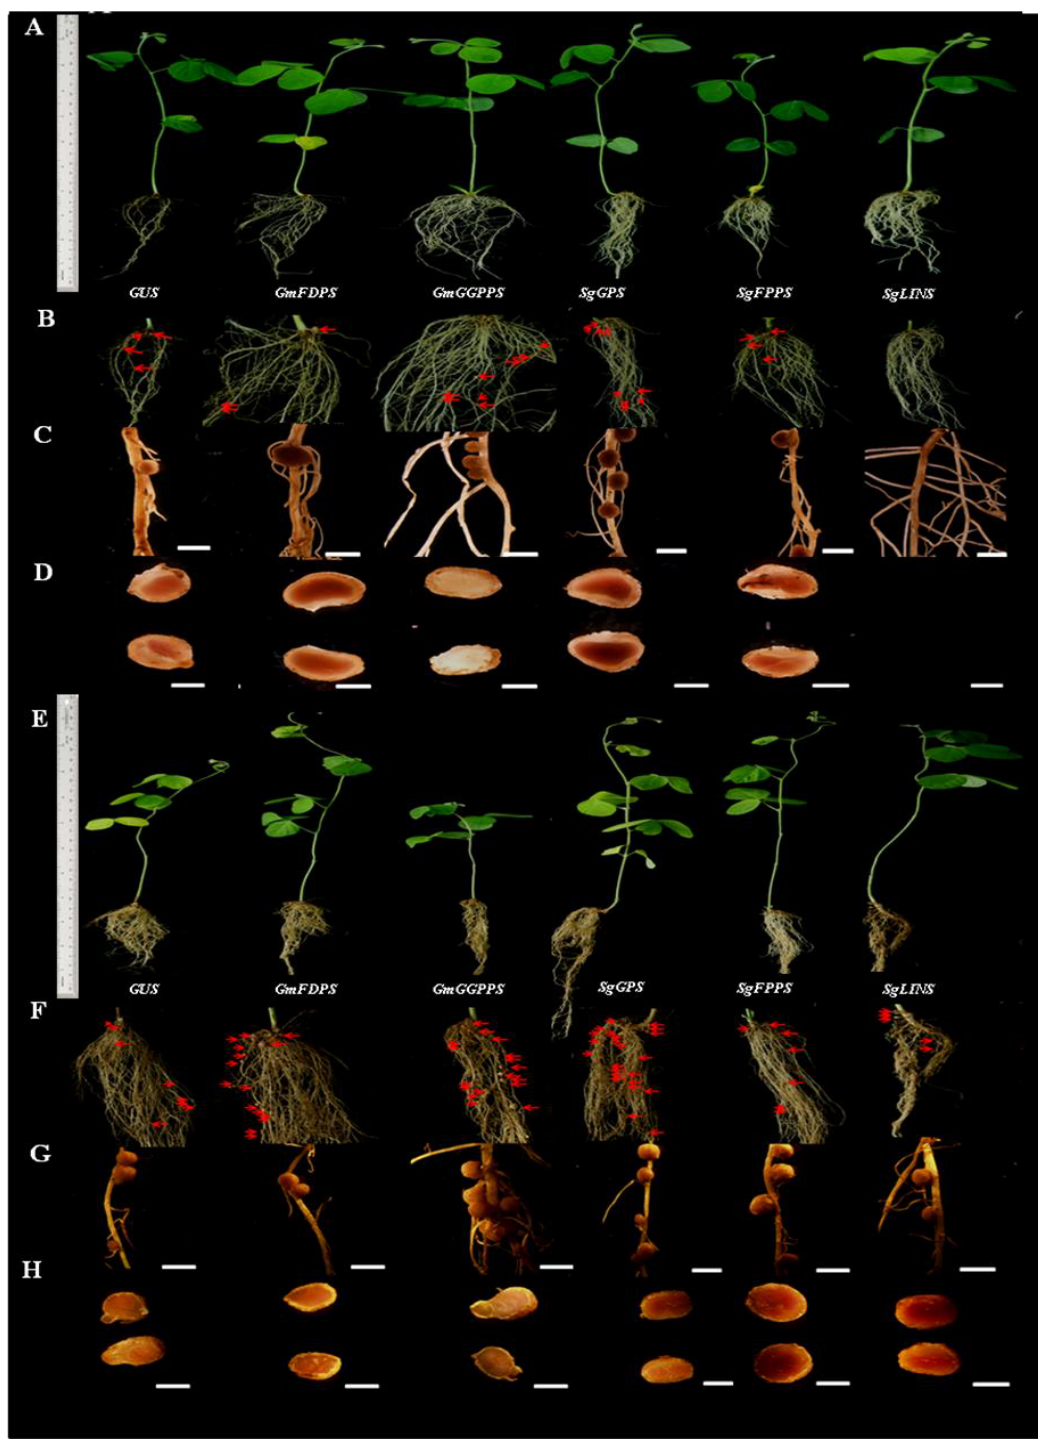
Figure 3. Effect of terpenoid gene overexpression on soybean root nodulation. Roots and nodules were examined at 10th and 20th day after rhizobia inoculated with B. japonicum strain USDA110. Composite plants were generated by transformation with the K599 vector harboring overexpression cassettes for GUS (control), GmFDPS, GmGGPPS, SgGPS, SgFPPS and SgLINS . Roots were inoculated with rhizobia. ( A , E ) Root and shoot phenotypes of 10- and 20-d-old G. max plants. ( B , F ) Locations where nodules formed on hairy roots overexpressing 10- and 20-days after rhizobial inoculation. ( C , G ) Nodules developed on secondary roots. ( D , H ) Cross-sections of G. max nodules. Photographs in ( C , D , G , H ) were taken with a DP-73 microscope camera set (Olympus, Tokyo, Japan). Scale bars in ( C , D , G , H ) = 500 µ